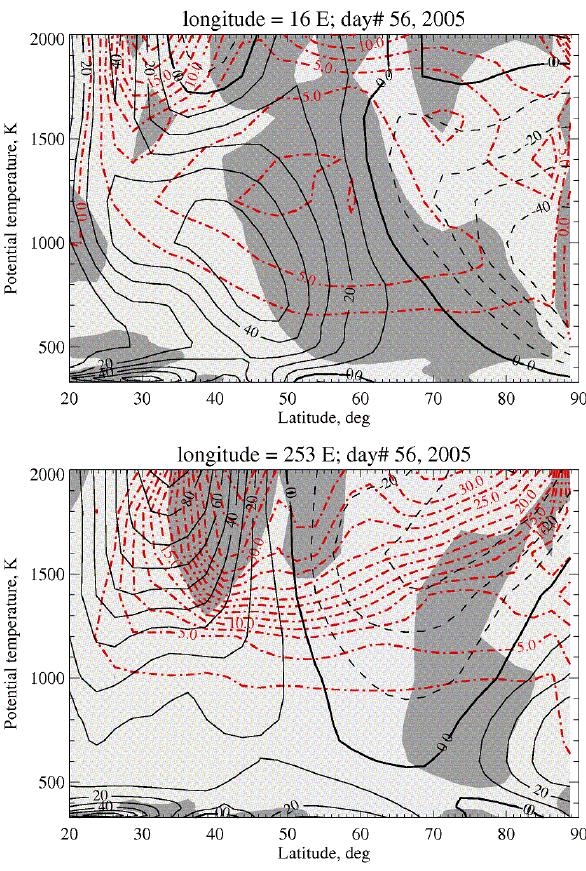
Fig. 5a. Latitude-altitude cross sections of the Q parameter (dark grey is negative, light grey is positive) at 16 ◦ E (top) and 253 ◦ E (bottom) longitudes on 25 December 2004 (day number 360). Solid and dashed lines are positive (eastward) and negative (westward) MetO zonal winds (m/s), respectively. Dash-dot lines are contours of modified PV (1PV unit=10 − 6 m 2 Ks − 1 kg − 1 ) .